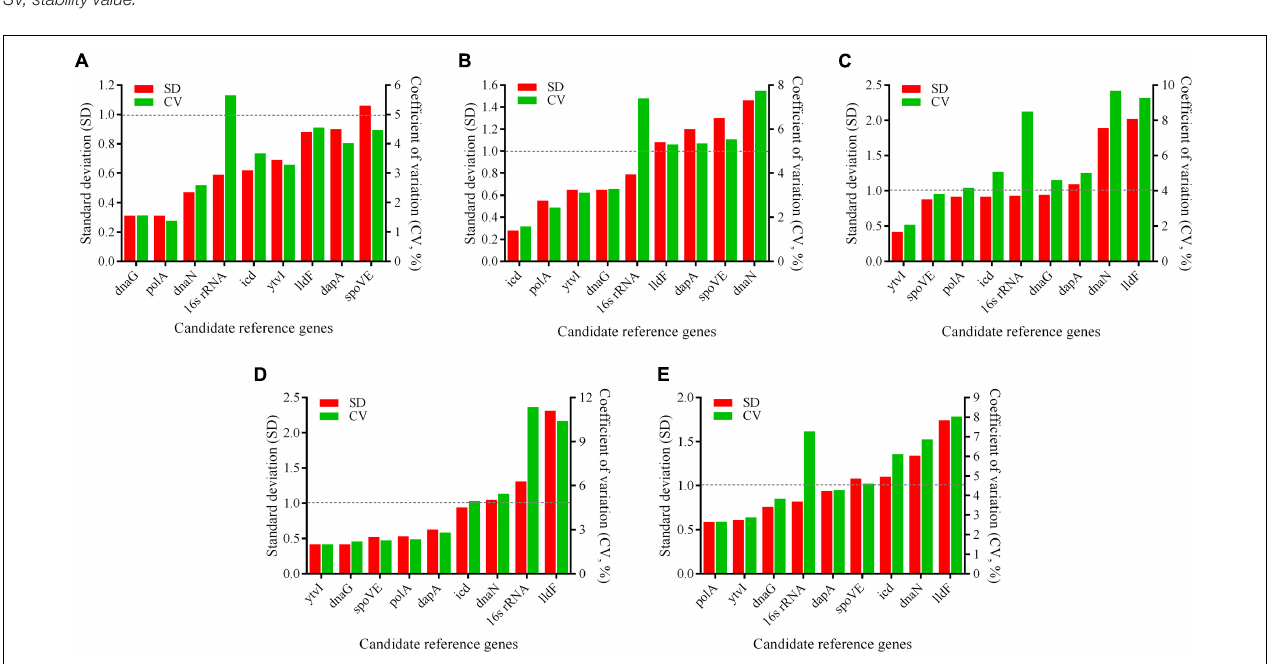
FIGURE 6 | Expression stability of candidate reference genes in A. acidoterrestris assessed by BestKeeper program. (A–D) A. acidoterrestris cells treated at pH 4.0, 3.5, 3.0, and 2.5, respectively. (E) All samples. SD, standard deviation; CV, coefficient of variation.